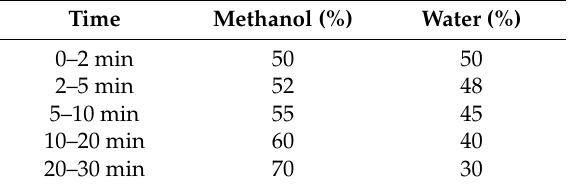
Table 2. HPLC gradient profile for purification of hesperetin